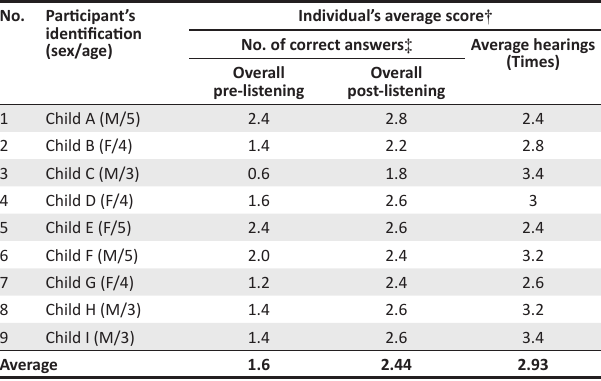
TABLE 4: Average score of tests and the number of hearing